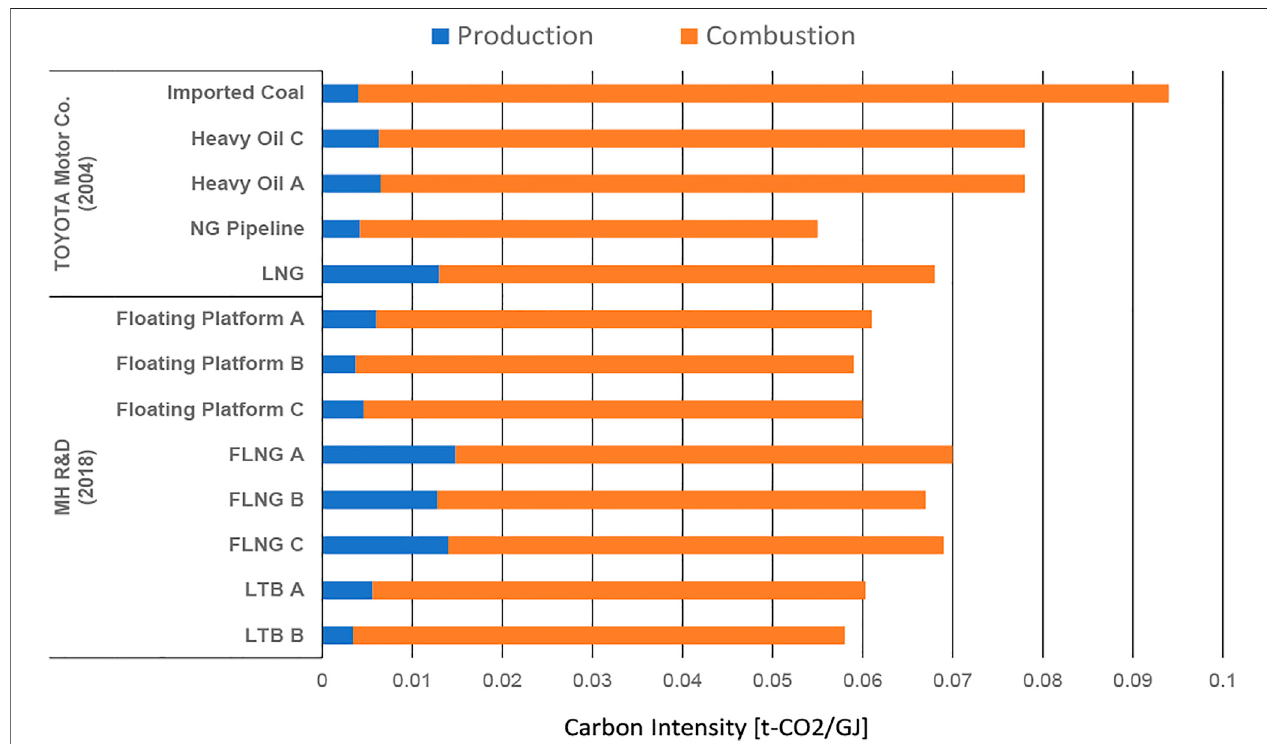
FIGURE 10 | Carbon intensity of each energy — emission from the production process and combustion of products.